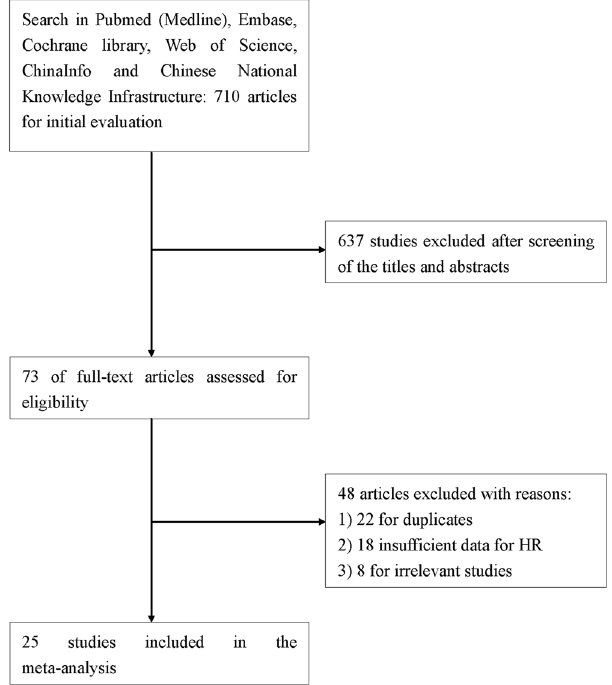
Figure 1. Flow diagram of the study selection